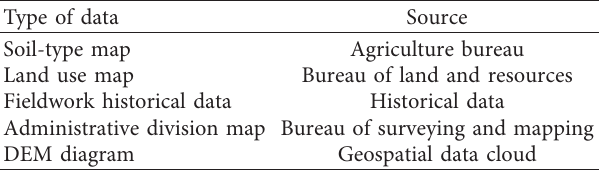
Table 2: Nonremote sensing data